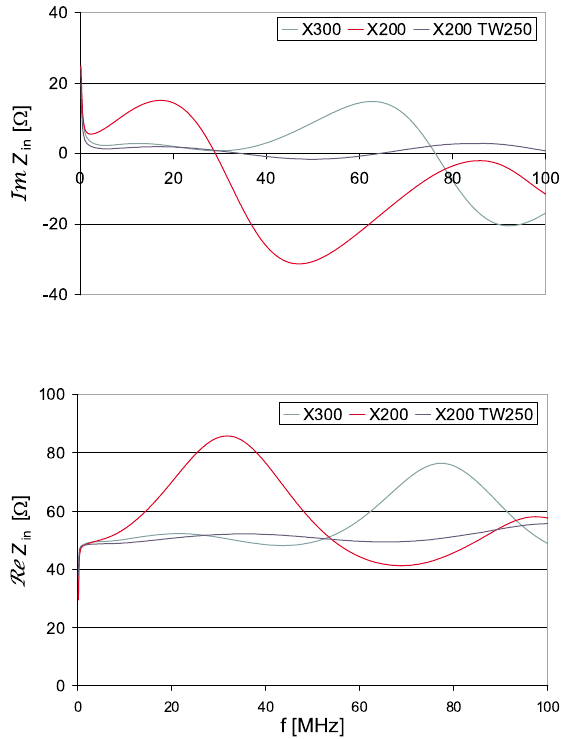
FIG. 3. (Color) Input impedance of TW-line with different transformers.